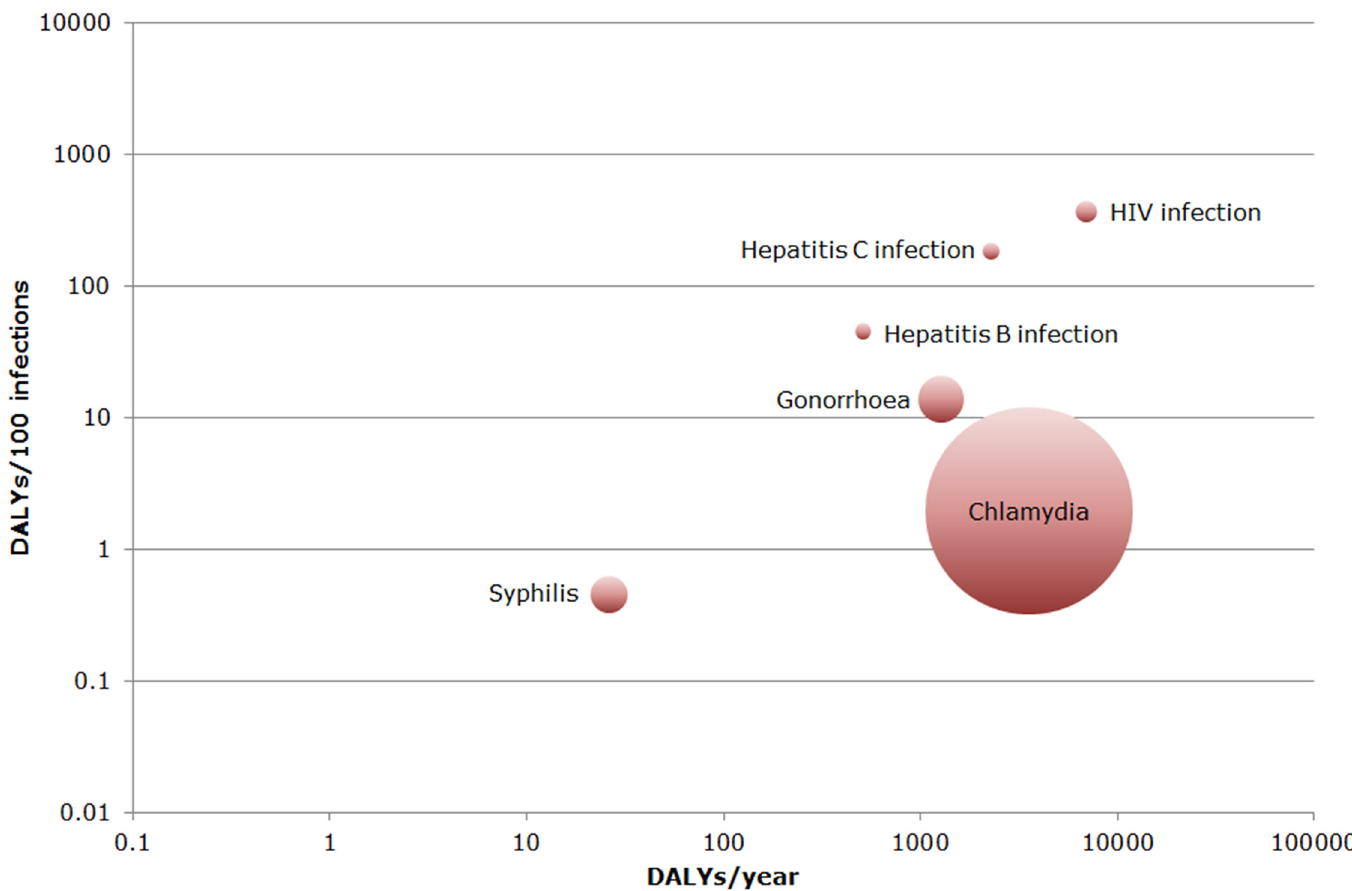
Fig 2. Ranking of sexually-transmitted infections by disease burden at population/individual level in the Netherlands in 2007 – 2011. The area of each bubble is proportional to the average number of estimated annual cases. Both axes are on a logarithmic scale.(DALY = Disability-Adjusted Life Years, population level = number of DALYs/year, individual level = number of DALYs/100 infections).